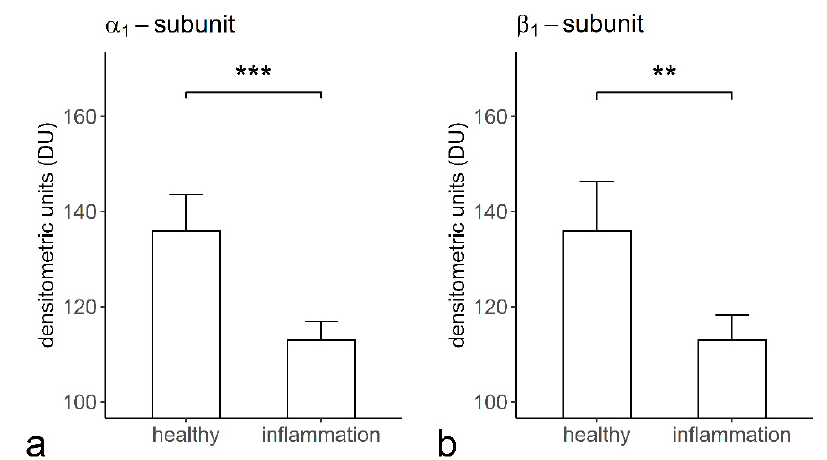
Figure 7. The staining intensities of the α 1 - and β 1 -subunits of sGC in cementoclasts of the healthy and inflamed human periodontium: staining intensity of the α 1 -subunit in cementoclasts, as assessed in sections of healthy ( n = 6) and inflamed ( n = 6) periodontium by densitometric analysis ( a ), and staining intensity of the β 1 -subunit in cementoclasts, as analyzed in sections of healthy ( n = 6) and inflamed ( n = 6) periodontium by densitometric analysis ( b ). Data are presented as mean ± standard deviation (SD). The significant differences between two groups were presented with an asterisk ( a , *** p < 0.001; b , ** p < 0.01).